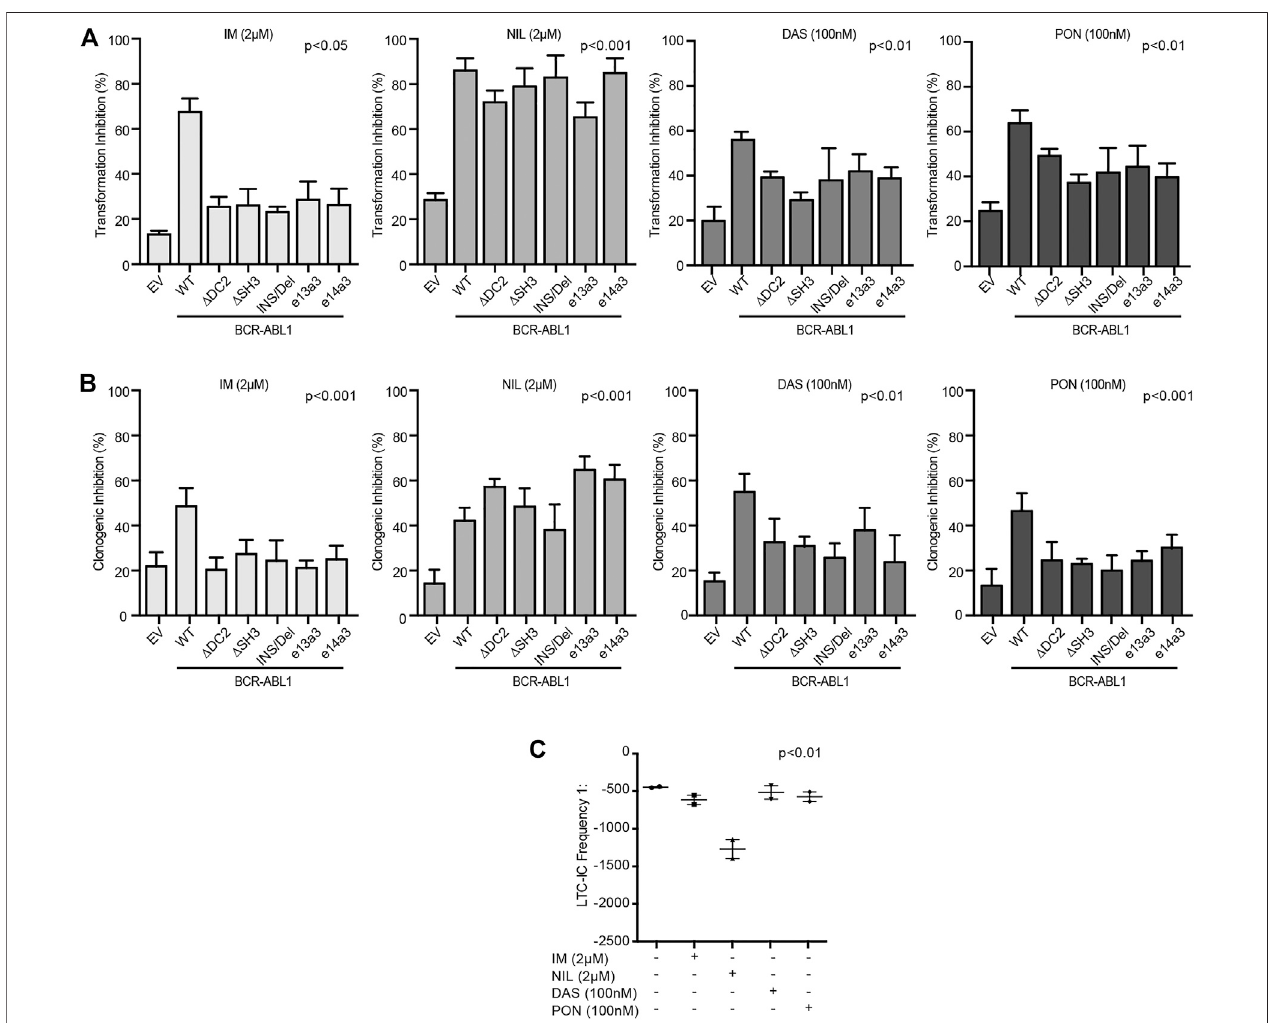
FIGURE6| CD34-positivecellsexpressingatypical BCR-ABL1 transcriptsarehighlysensitivetoNIL. (A , B) Histogramsindicatingthepercentageoftransformation (A) and clonogenic (B) inhibition ofCD34-positive cellsexpressing theindicatedBCR-ABL1constructsand exposed todifferentTKIs. Percentage valueswereobtained setting untreated cells for each condition to 100%. Bars indicate the standard deviation of two experiments performed in duplicates. (C) Dot plot showing the LTC-IC frequency of CD34-positive cells derived from a CML patient expressing e14a3 BCR-ABL1 after no treatment or exposure to TKIs at the indicated concentrations. All experiments were performed in